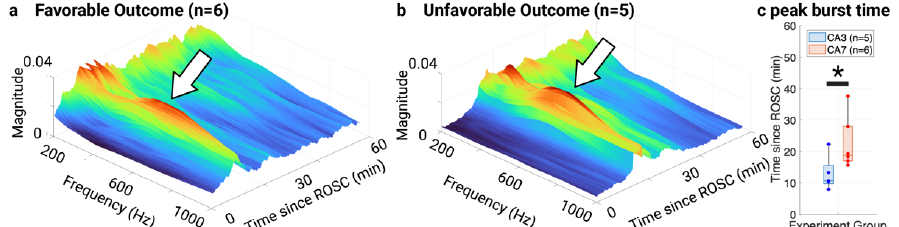
Figure 8. HFOs experienced a sudden burst post-ROSC for both outcome groups. The frequency spectrum of HFOs was plotted from 0 min to 60 min post-ROSC. The largest magnitude CWT coefficients for each frequency in the time window of 10 to 20 ms were extracted to represent the HFO spectrum. The left axis spans from 200 Hz to 1000 Hz; the right axis spans from 0 min to 60 min since ROSC; the vertical axis represents the magnitude of HFO at a particular frequency. ( a ) HFO spectrum for favorable outcome group. ( b ) HFO spectrum for unfavorable outcome group. ( c ) Peak burst time for both injury groups CA3 and CA7. * p < 0.05. Created with Biorender.com.